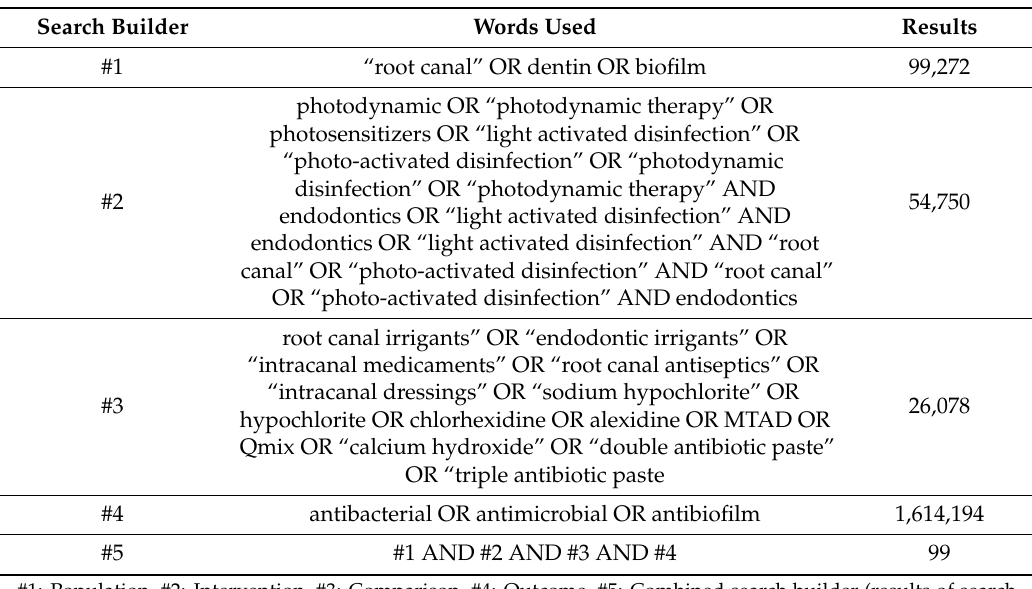
Table 1. Key words used for search strategy in PubMed.